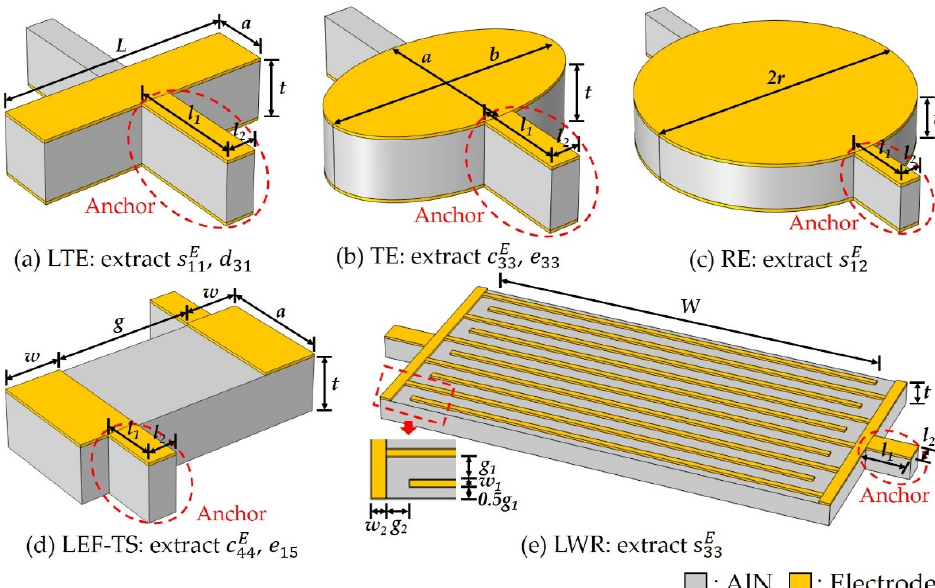
Figure 1. The schematic diagrams of BAW resonators with ( a ) length thickness extension, ( b ) thickness extension, ( c ) radial extension, ( d ) lateral electric field excited thickness shear modes and ( e ) lamb wave resonator. These resonators are suspended in the air, and the anchors on both sides circled in red dash lines are used for supporting and introducing electrical signals.